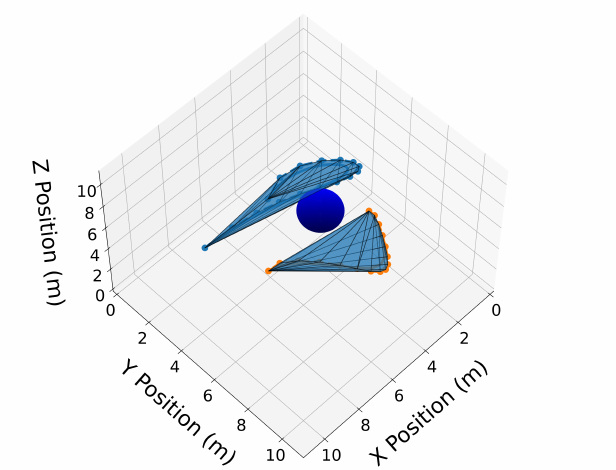
Figure 13. Trajectories C [ 3 ] ( t ) and C [ 4 ] ( t ) split at t div = 15 s. Convex hulls are drawn around the Bernstein coefficients of the new split trajectories.